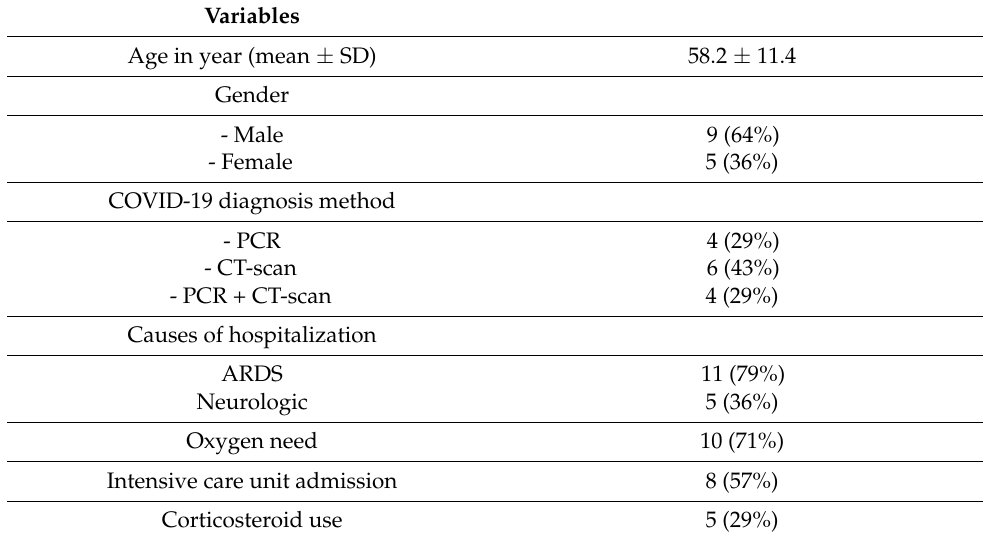
Table 1. Baseline and medical characteristics of included patients. ARDS: acute respiratory distress syndrome; CT: computed tomography; PCR: polymerase chain reaction; SD: standard deviation.